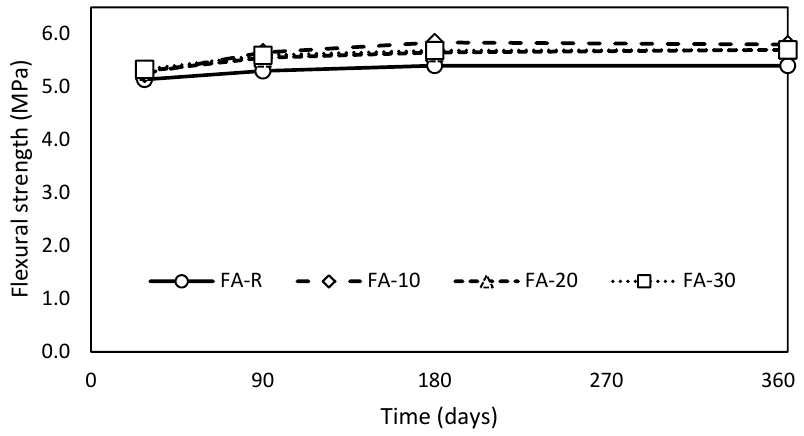
Figure 3. Evolution of flexural strength in